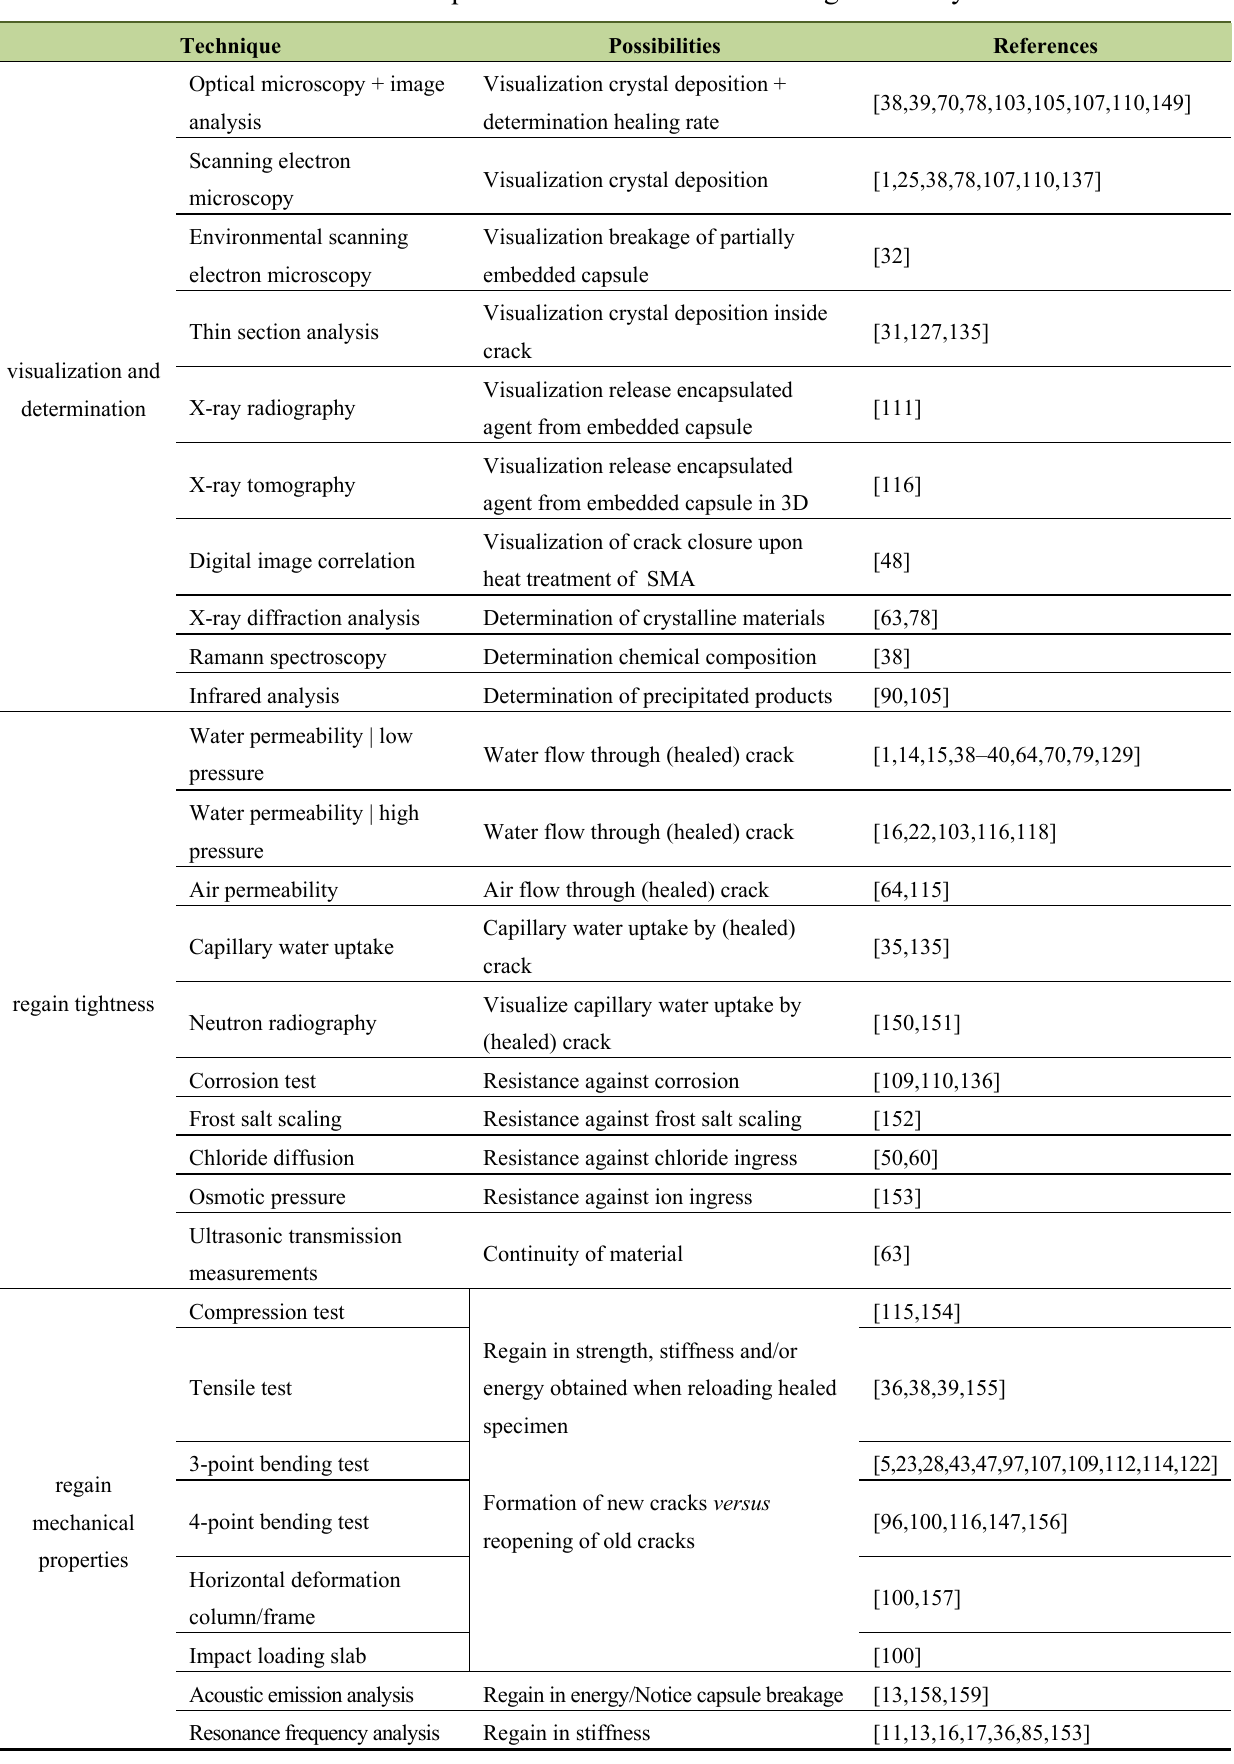
Table 4. Techniques used to evaluate the healing